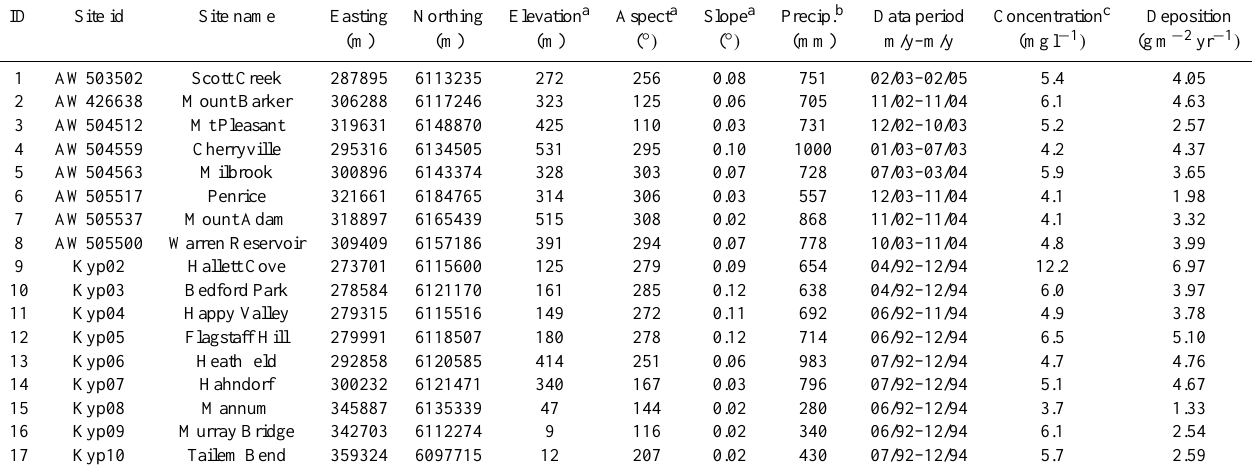
Table 1. Bulk chloride deposition and concentration over the Mount Lofty Ranges calculated from samples collected over two periods by DWLBC (1–8) and Flinders University (9–17), and associated site information.